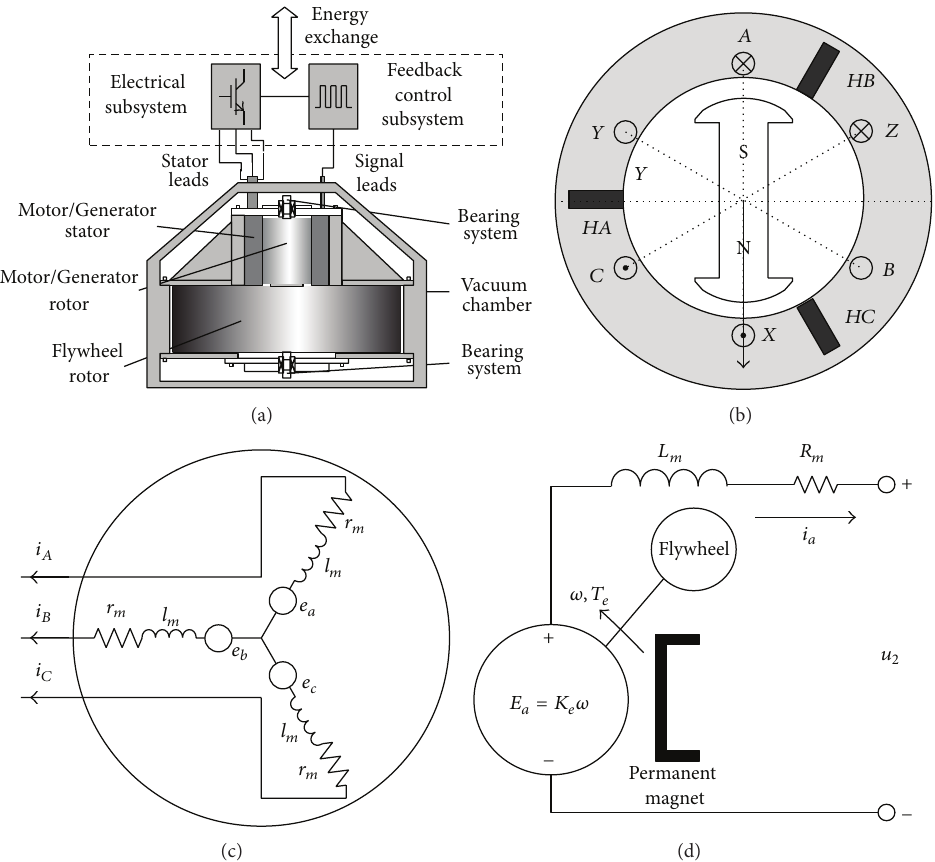
Figure 3: Flywheel motor system: (a) physical structure, (b) schematic diagram, (c) three-phase equivalent circuit, (d) two-phase conducting equivalent circuit (the current direction corresponds to the generator operation).